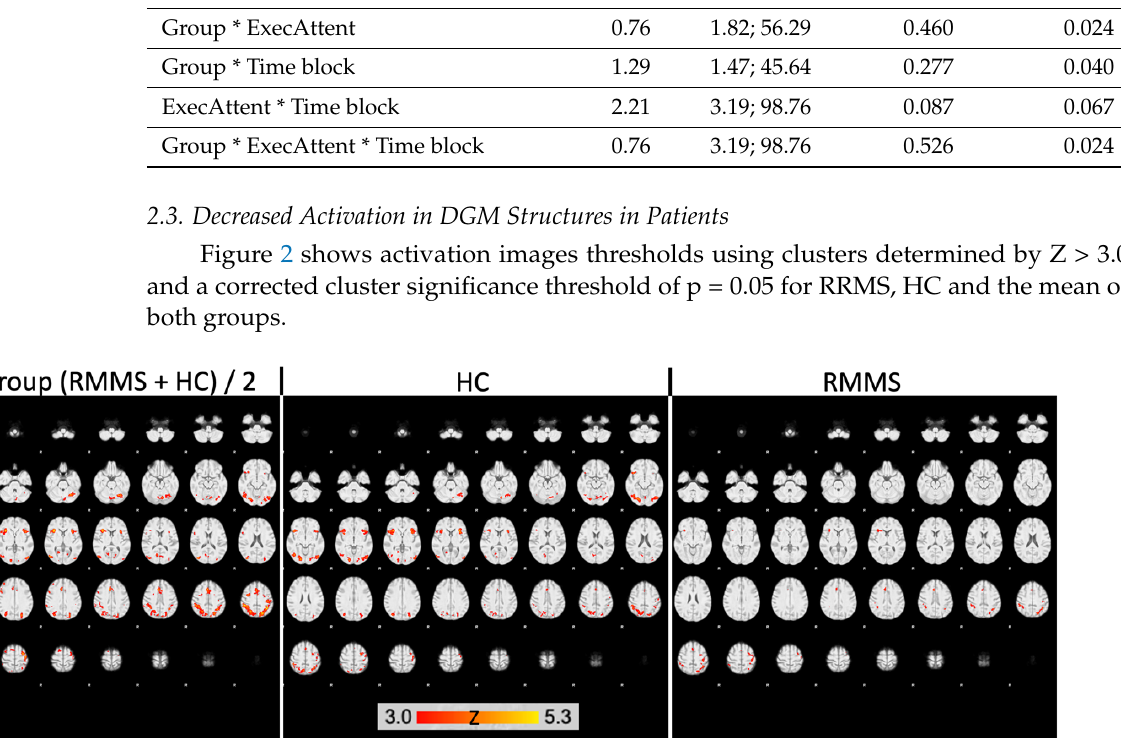
Figure 2. Activation images thresholds using clusters determined by Z > 3.0 and a corrected cluster significance threshold of p = 0.05. Images are shown for RRMS, HC and the mean of both groups. Table 4. Activation by ExecAttent in healthy controls (HC) and patients with RRMS (MS): Results of permutation tests using threshold-free cluster enhancement. Clusters containing only voxels with pFWE < 0.05 and their maximum with MNI coordinates are shown. Bonferroni threshold is pB =